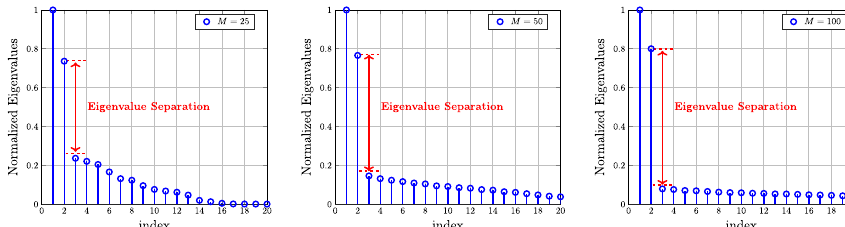
Fig. 3 Eigenvalue distribution for the sample covariance matrix (20) for different values of M and N / M =